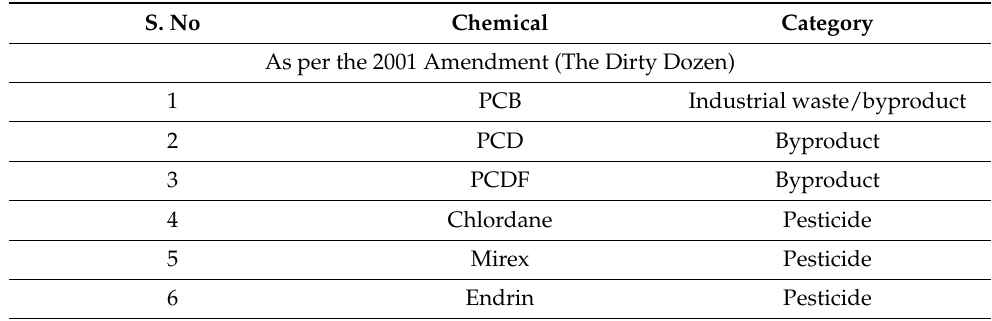
Table 1. List of POPs as per Stockholm